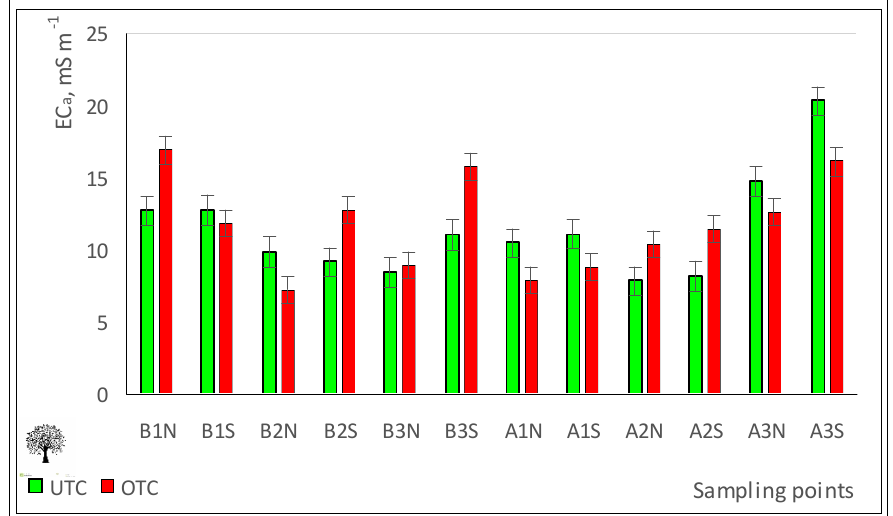
Figure 12. Apparent soil electrical conductivity (EC a ) in April 2016, outside tree canopy (OTC) and under tree canopy (UTC).